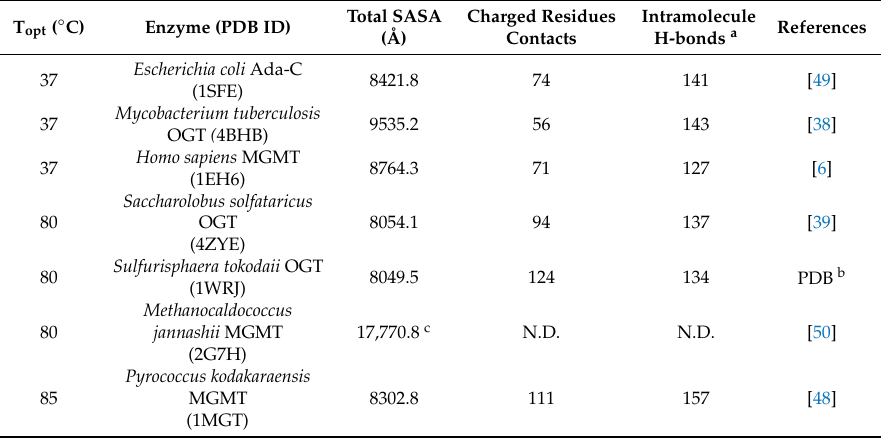
Table 2. Comparison of solvent-accessible surface area and intramolecule